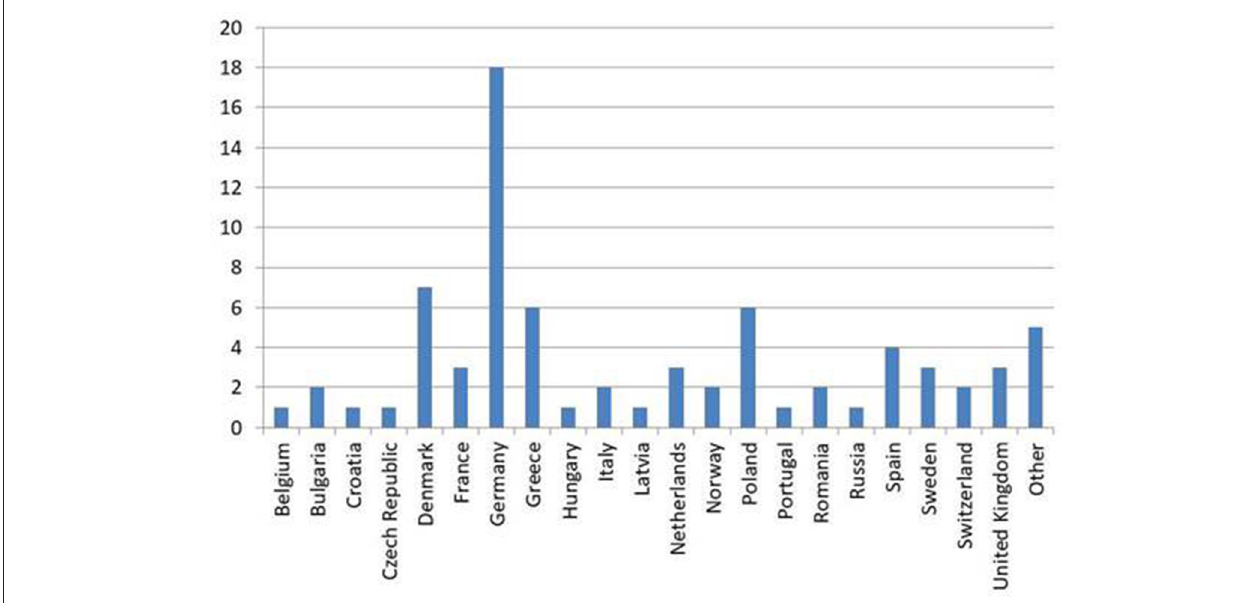
FIGURE 1 | Number of experts per country in the three